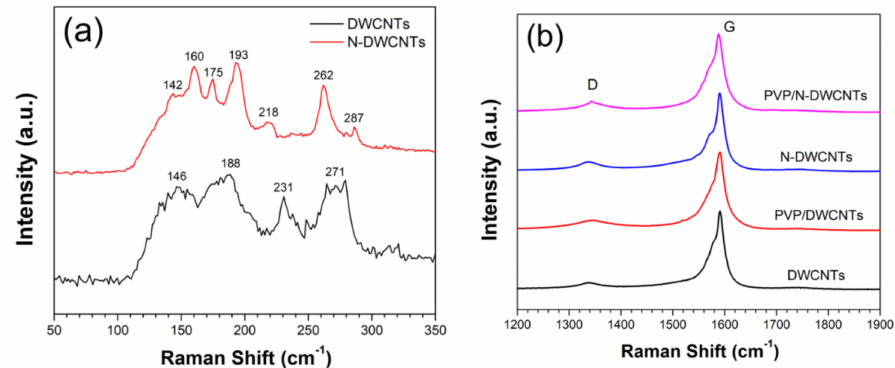
Figure 2. ( a ) RBM peaks of the DWCNTs and N-DWCNTs. ( b ) Raman spectra of all the samples.